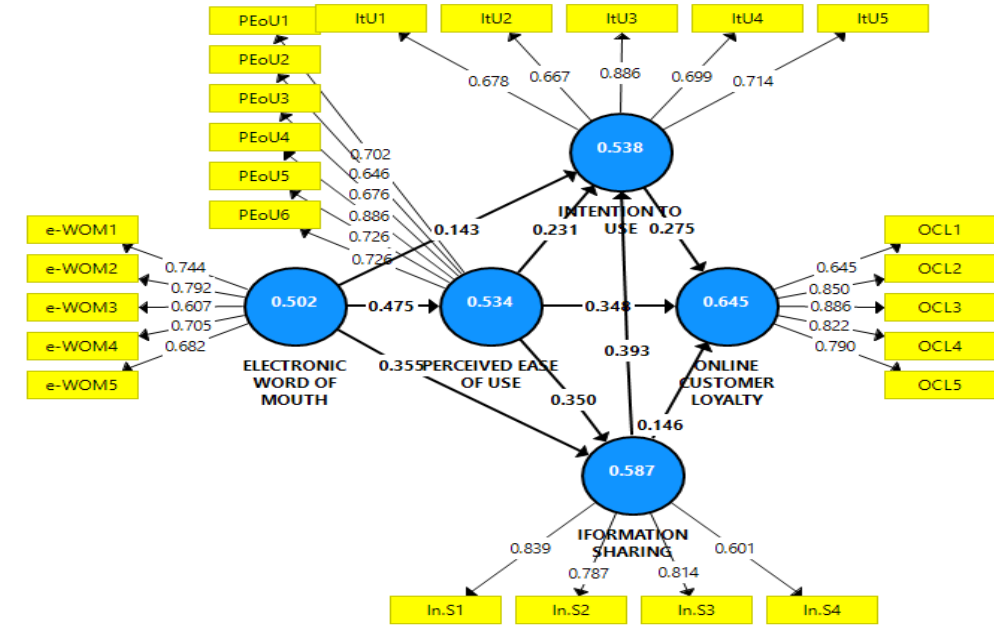
Fig. 2. Full Model Output PLS Hypothesis of